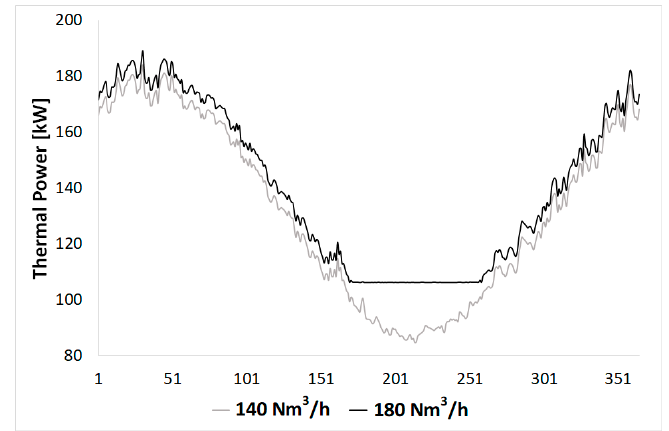
Figure 12. The total efficiency of the micro-gas turbine (mGT) (upgrader size of 180 Nm 3 /h).